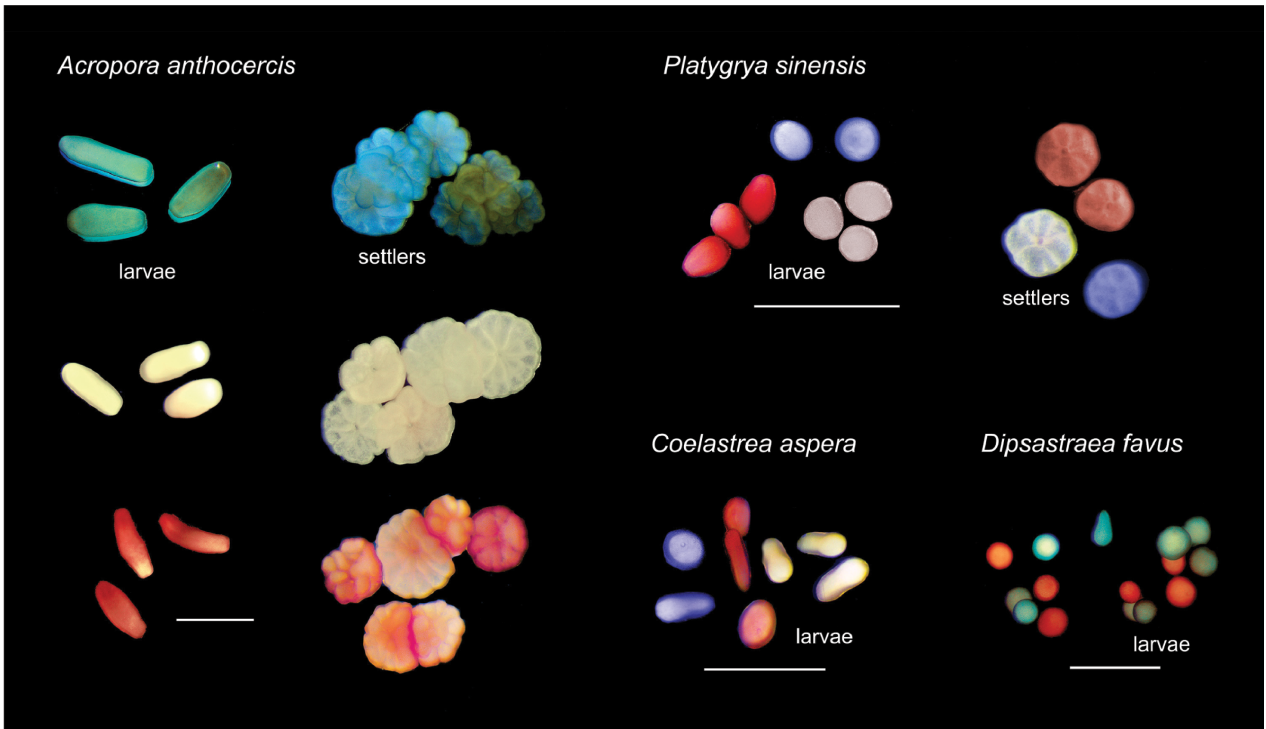
Fig 3. Representative images of free-swimming and newly metamorphosed larvae (Nile blue, unstained, neutral red) from A . anthocercis , P . sinensis , C . aspera , and mixed Nile blue and neutral red stained D . favus larvae. White scale bars = 1 mm. Images supplied by authors.